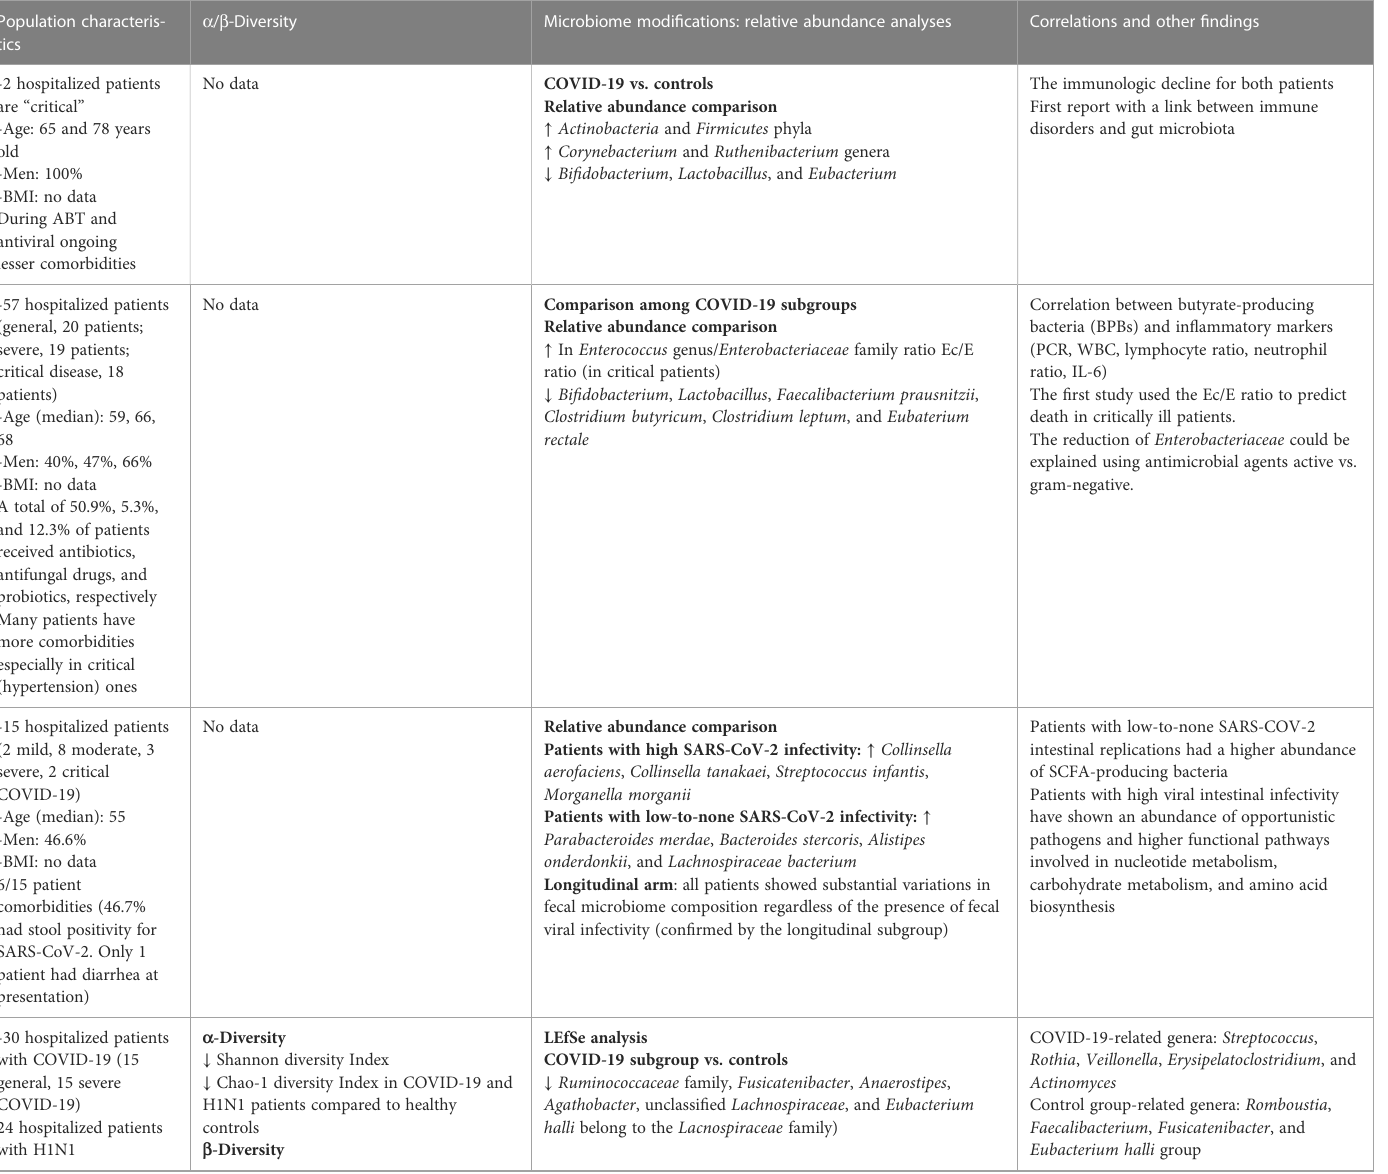
TABLE 1A Selected studies on gut microbiota and